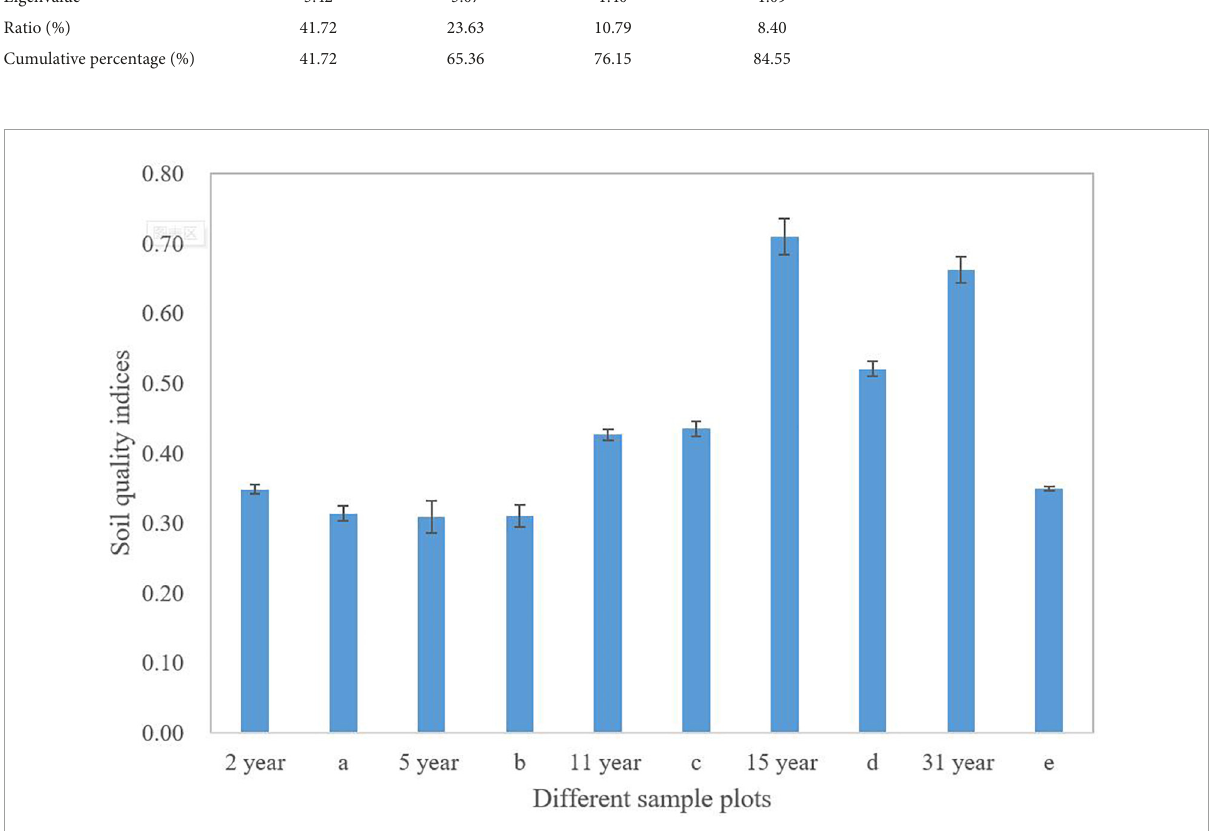
FIGURE7 Soil quality indices of the different afforestation plots based on the full data set.